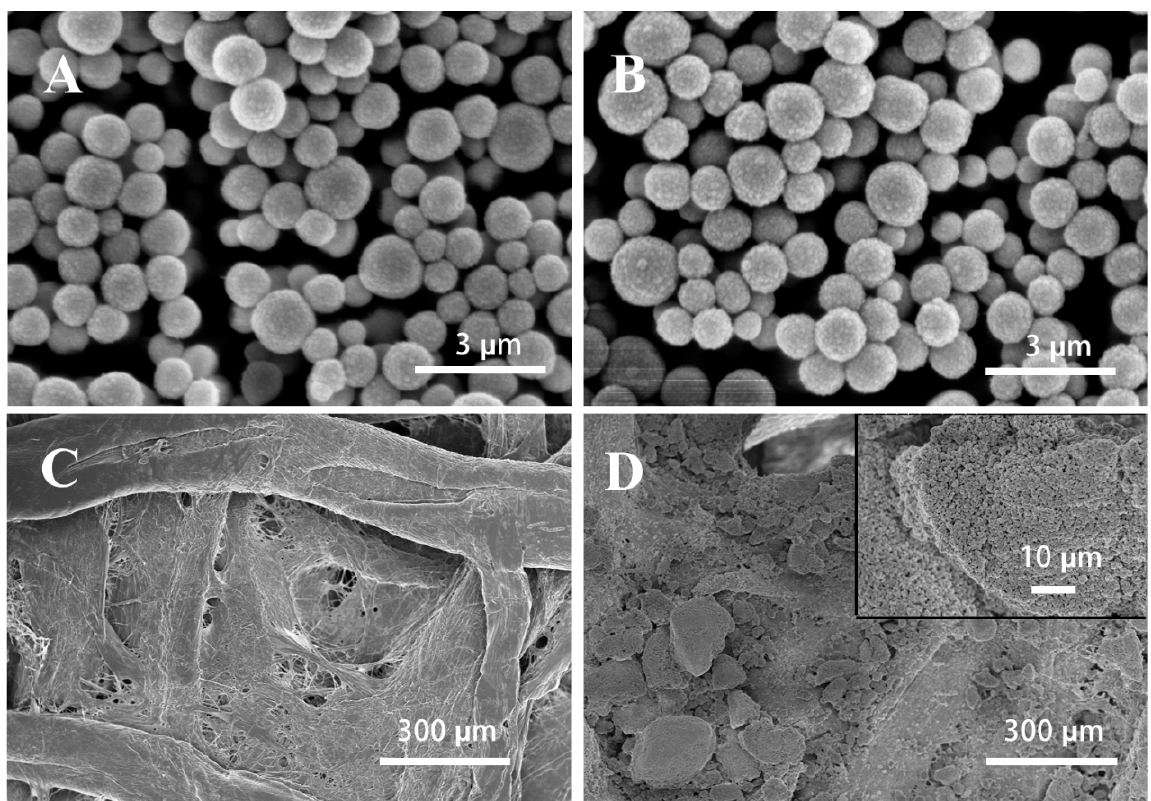
Figure 2. ( A ) SEM image of amino-modified SiO 2 , scale bars are 3 µm. ( B ) SEM image of QDs–SiO 2 , scale bars are 3 µm. ( C ) SEM image of Whatman No. 1 chromatography paper, scale bars are 300 µm. ( D ) SEM image of Whatman No. 1 chromatography paper titrated with QDs–SiO 2 , scale bars are 300 and 10 µm.